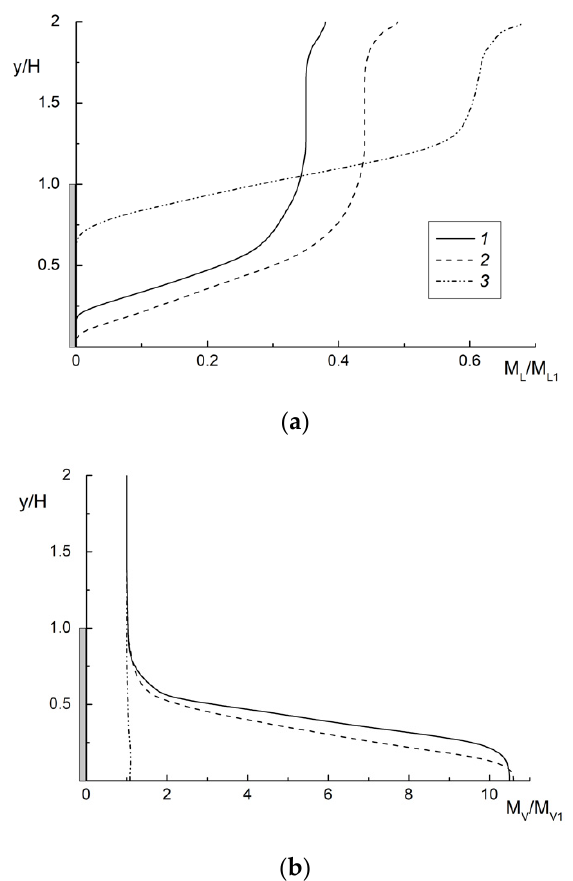
Figure 4. The transverse dictributions of ( a ) droplets and ( b ) steam mass fractions in the droplet-laden separated flow. x / H = 2, M L 1 = 0.05. 1: d 1 = 10 μ m, Stk = 0.03; 2: 30, 0.28; 3: 100, 2.9.